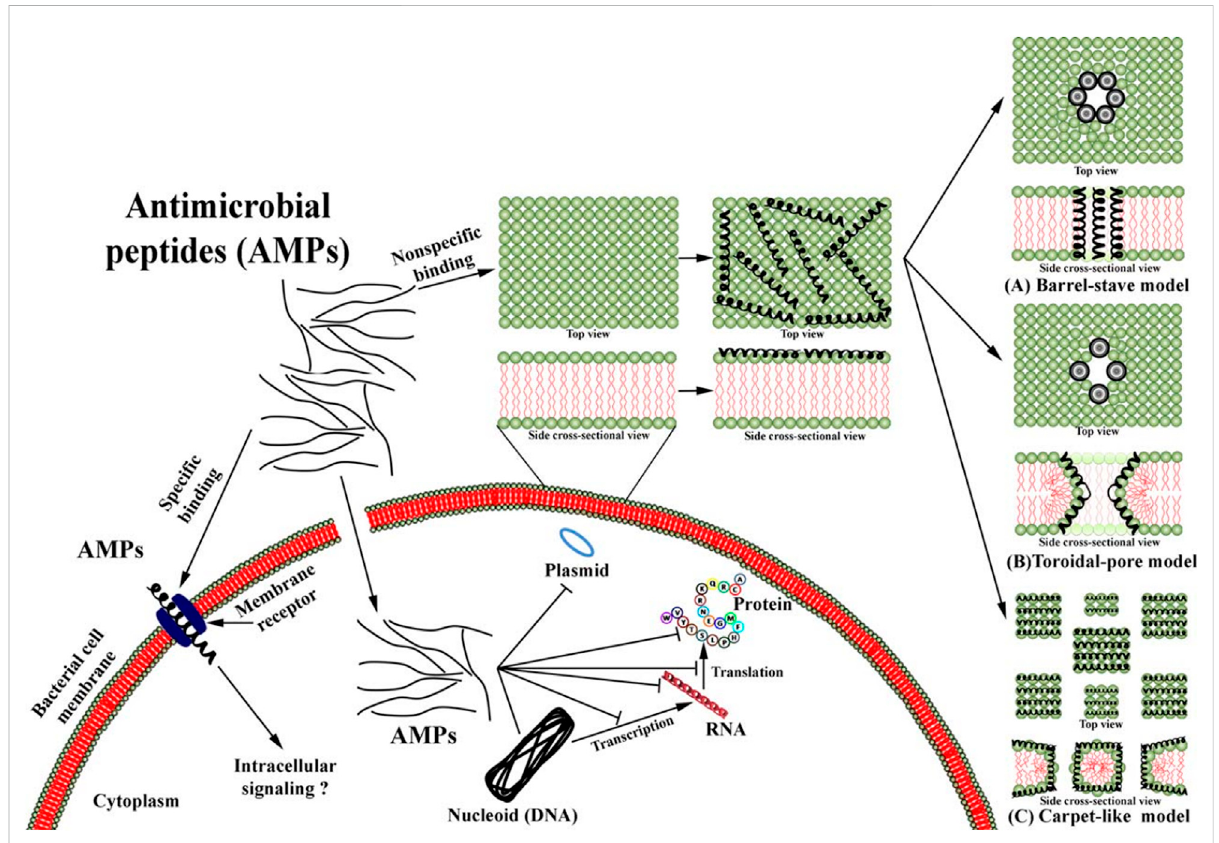
FIGURE 5 Overview of mechanism of action of AMPs from Ref (Ahmed and Hammami,